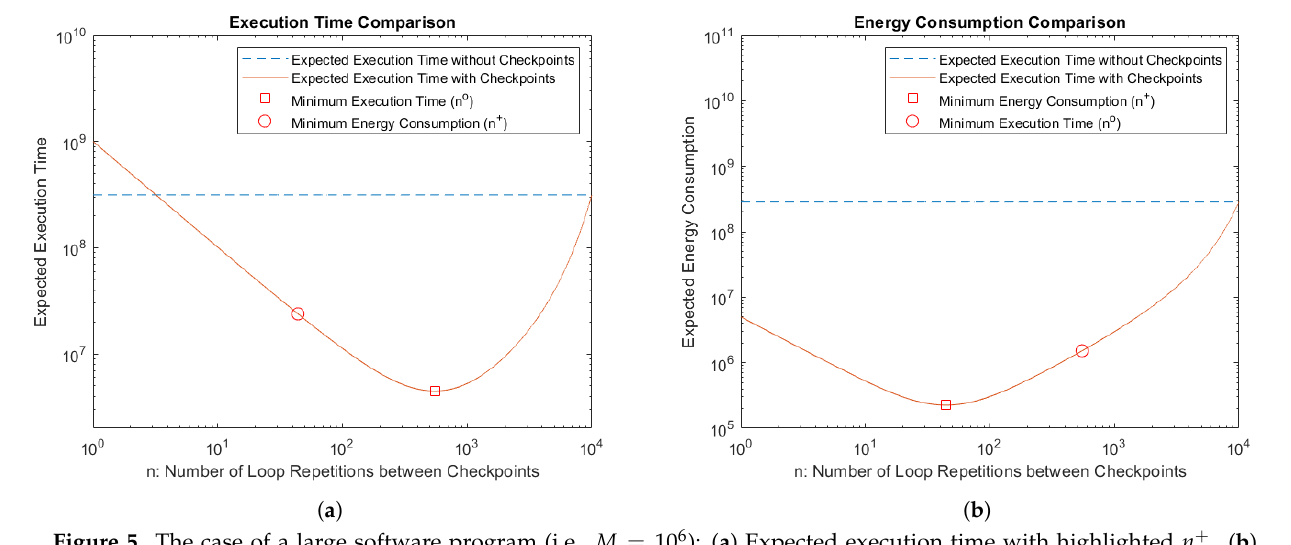
Figure 5. The case of a large software program (i.e., M = 10 6 ): ( a ) Expected execution time with highlighted n + . ( b ) Expected energy consumption with highlighted n o